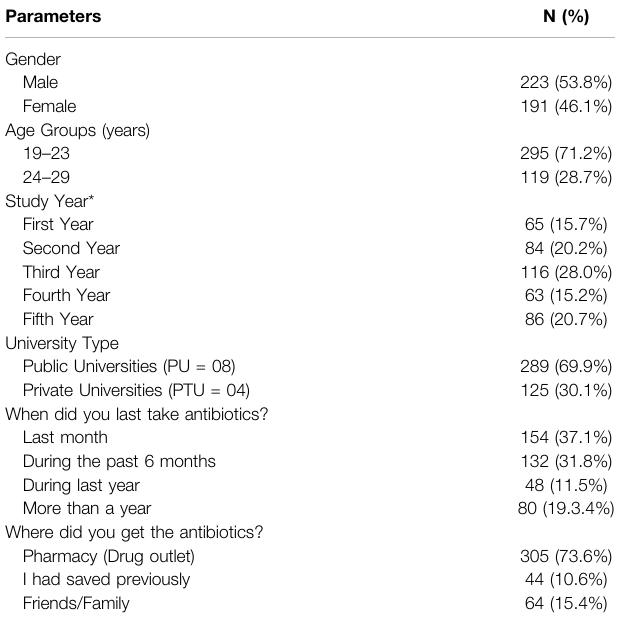
TABLE 1 | Undergraduate students demographics characteristics ( n (cid:1)